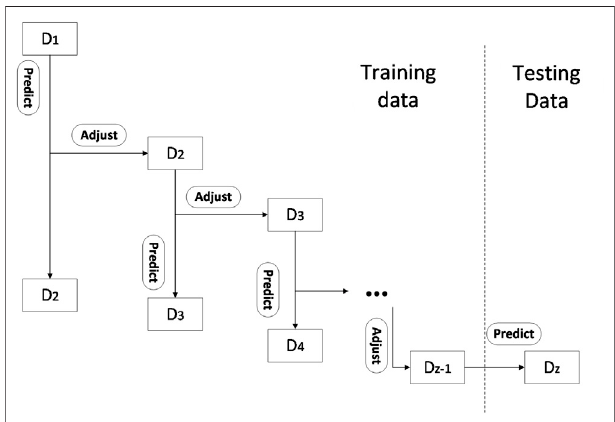
FIGURE 1| An illustration of dynamic parameter adjustment